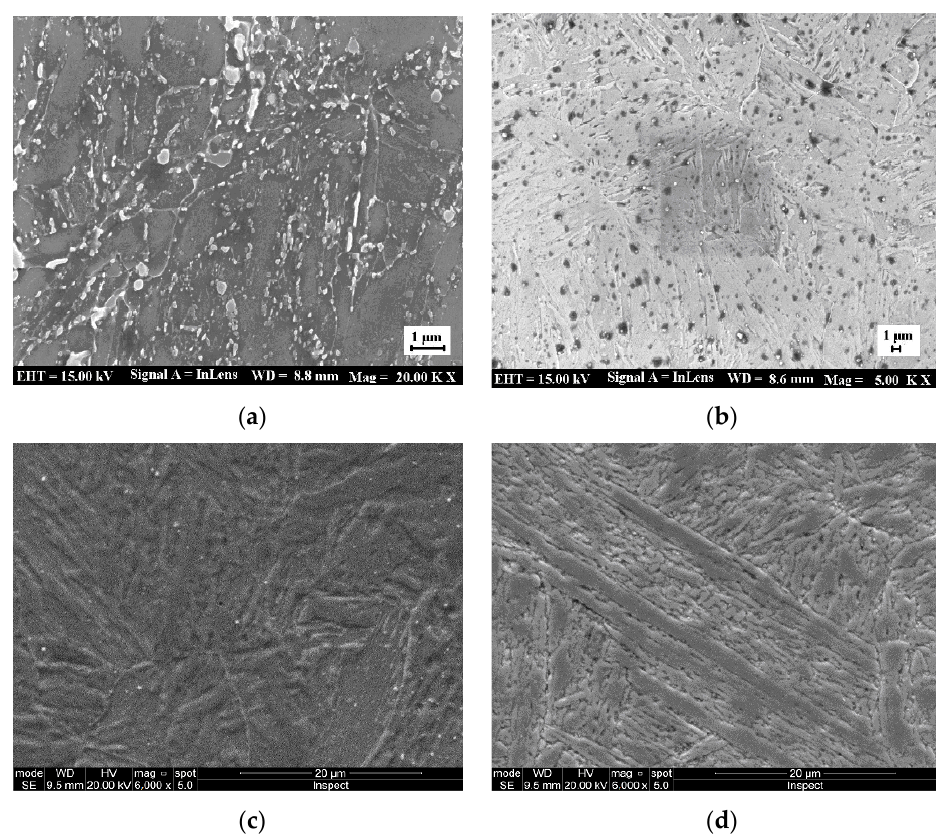
Figure 8. SEM-EDS analysis of X6CrNiMoVNb11-2 steel before and after heat treatment: ( a ) SEM-EDS before heat treatment; ( b ) SEM-EDS after the quenching and tempering processes; ( c ) α + Nb(C, N) by quenching; ( d ) α + Nb(C, N) + M 23 C 6 by quenching and tempering.